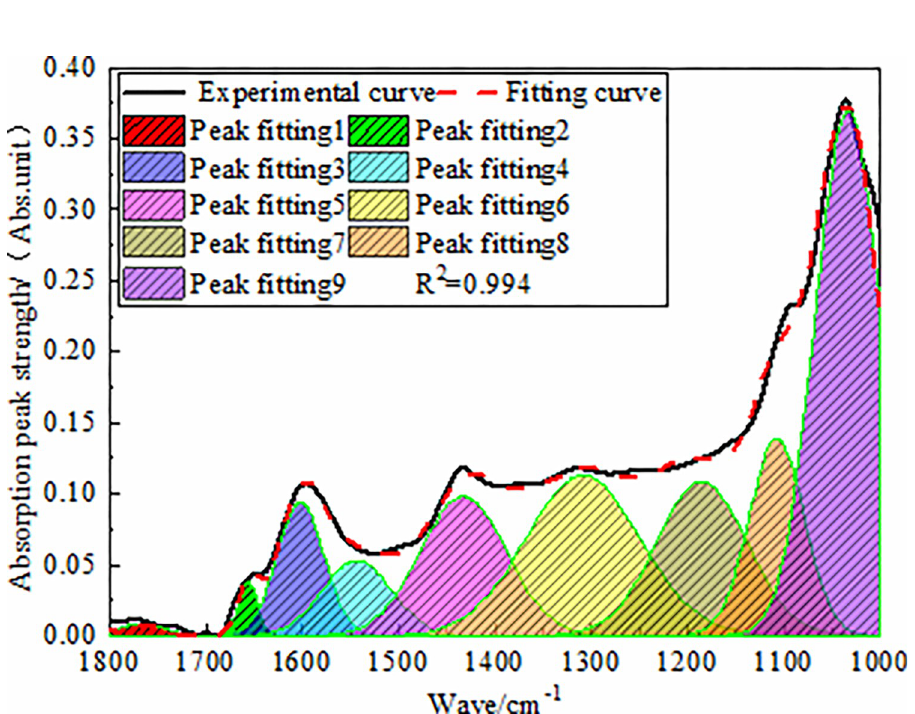
Fig 3. FT-IR fitting spectra of anthracite in 1800–100 cm -1 band.